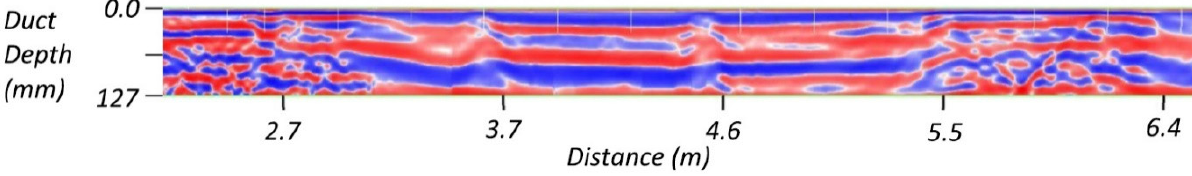
Figure 8. Photo captured by ground penetration radar [9].